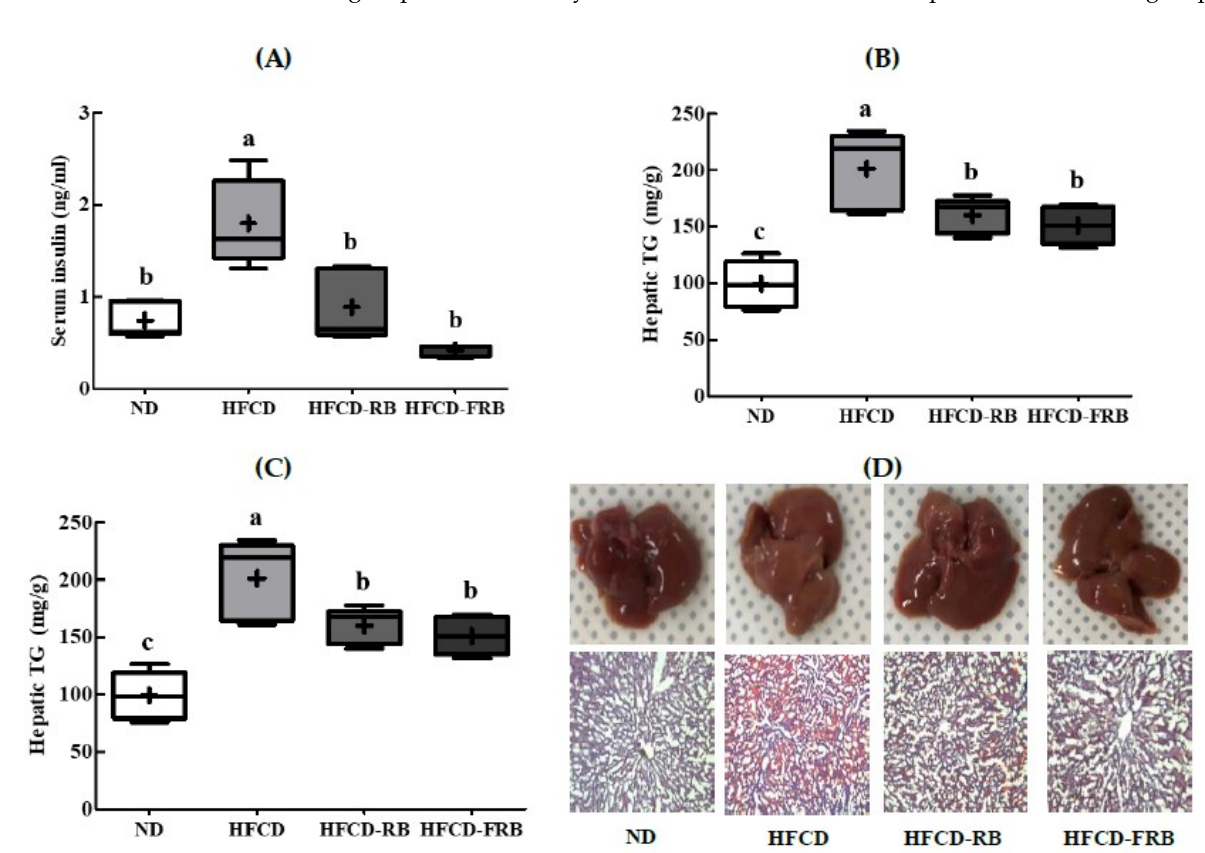
Figure 6. Hepatic lipid accumulation in mice fed experimental diets for 10 weeks. Diet groups: ND, normal diet group; HFCD, high-fat and -cholesterol diet group; HFD-RB, HFCD + non-fermented rice bran powder group; HFCD-FCA, HFCD + fermented rice bran powder group. ( A ) Hepatic lipid, ( B ) hepatic triglyceride (TG), and ( C ) hepatic total cholesterol were measured; ( D ) liver samples were sliced, fixed and stained with Oil-red O. Values are displayed as a Box-and-Whisker plot with means (expressed as ‘+’), n = 10. a–c: bars with different letters are significantly different at p < 0.05 by Tukey’s post hoc test.